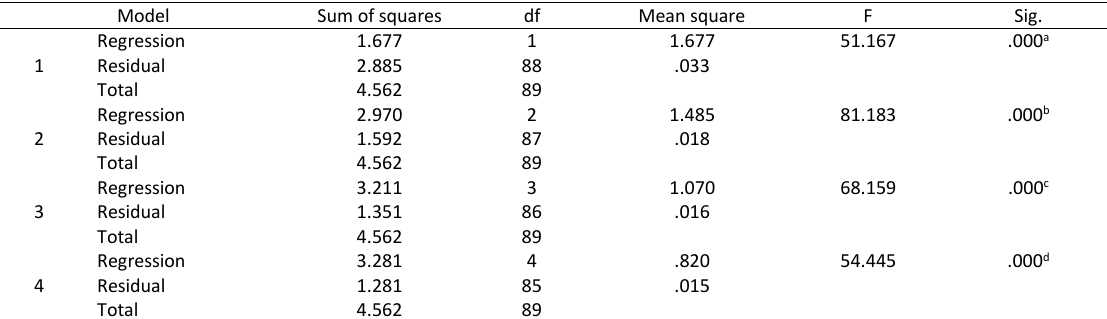
Table 5: Analysis of variance for solid waste prediction model development